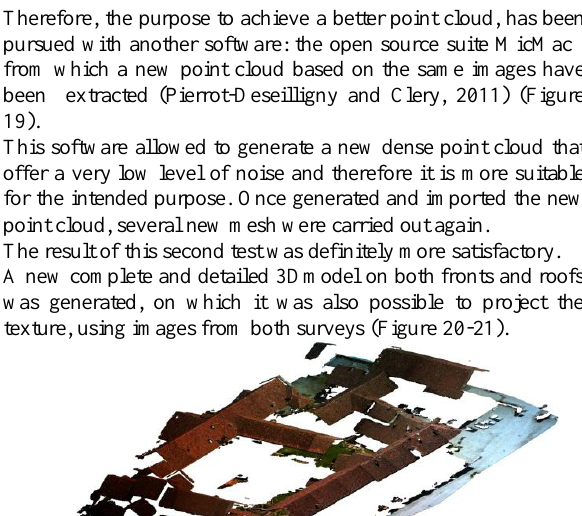
Figure 16. Point clouds data fusion